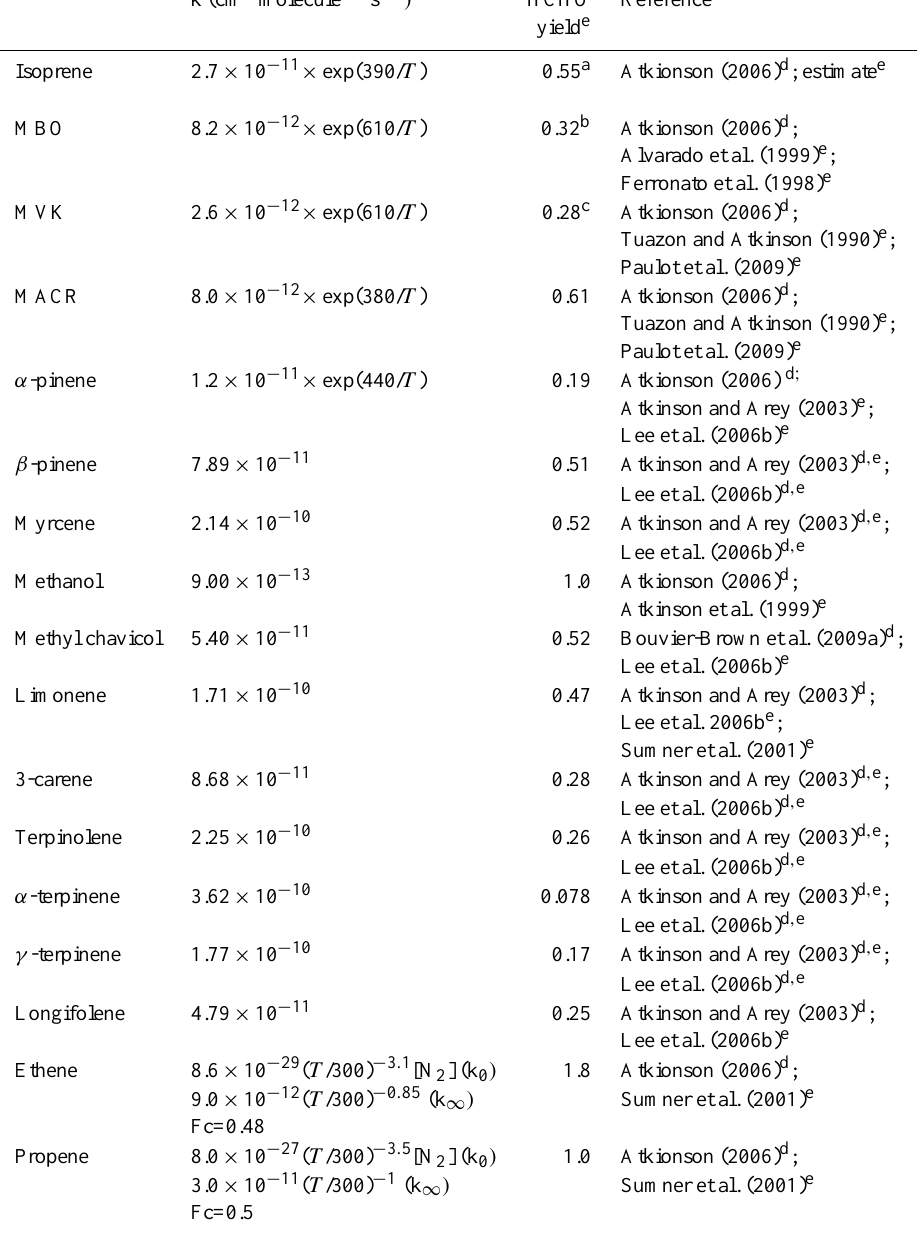
Table 2. Reaction rate constants k for reaction of biogenic VOCs with OH and HCHO